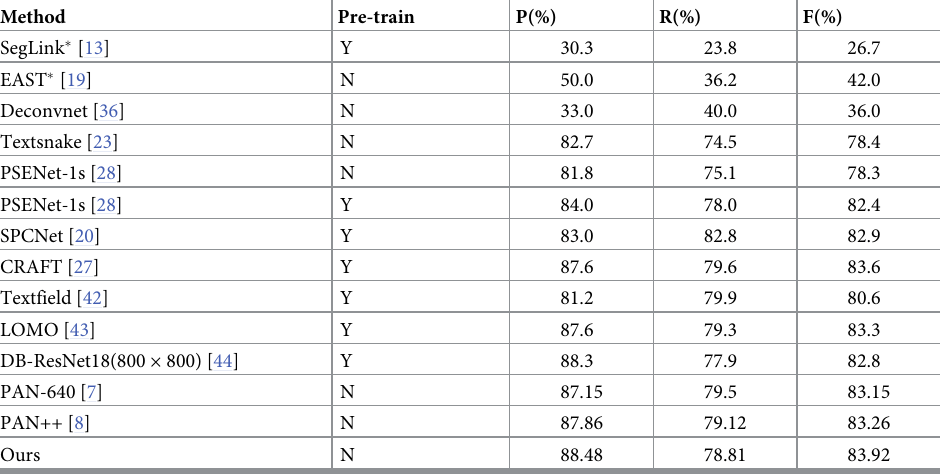
Table 5. Results at 640 × 640 on total-text dataset, pre-train represents whether to use the pre-training dataset for fine-tuning. “Y” means using pre-training, “N” means not using pre-training. “P”, “R” and “F” stand for “precision”, “recall” and “F-measure” respectively. � indicates the results from [7]. PAN++ [8] is the detection module.